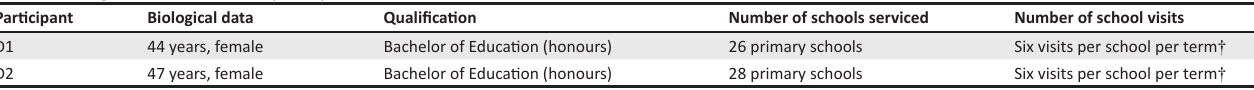
TABLE 1: Background information of